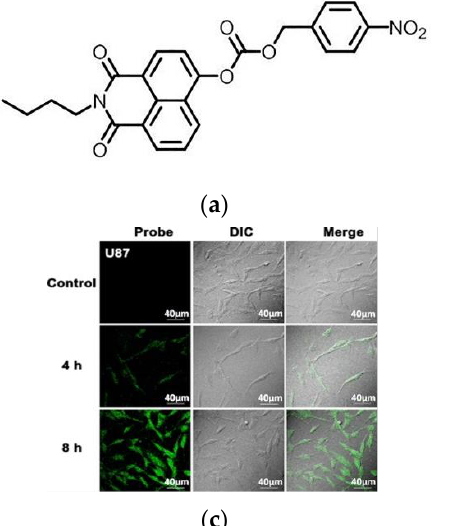
Figure 8. ( a ) Structure of probe 2; ( b ) Fluorescence intensity of the probe reacted in the presence of NTR; ( c ) Laser confocal fluorescence images of U87 cells under the condition of normoxic (20% O 2 )